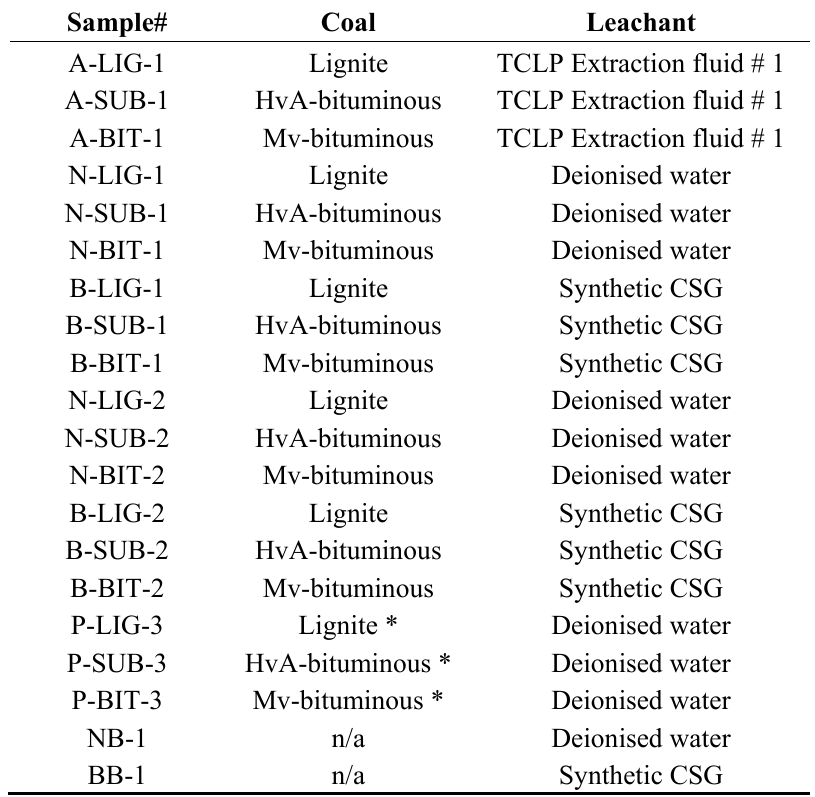
Table 1. Leaching experiments and conditions. All experiments were performed at room temperature (25 °C) for 18.5